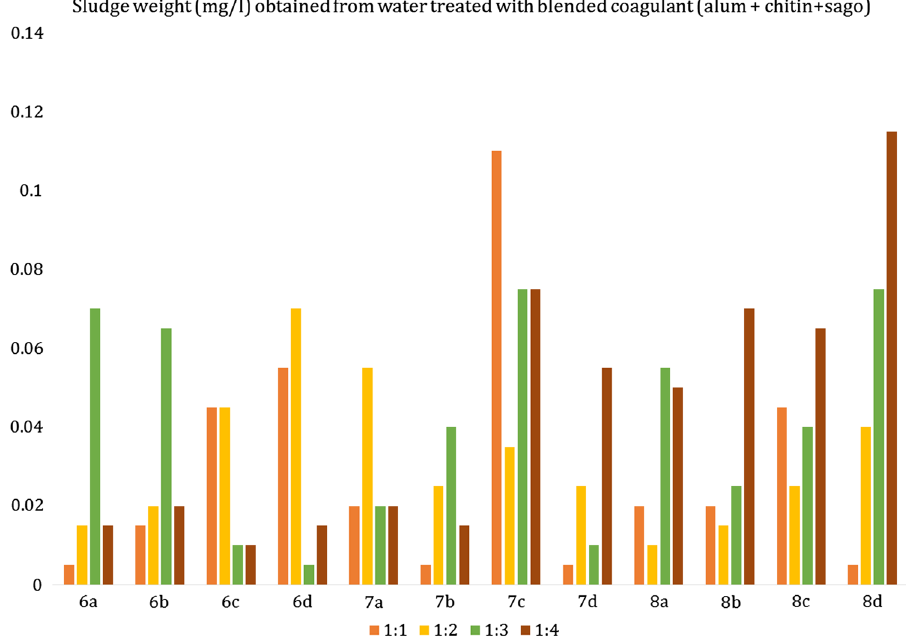
Fig. 4 Sludge weight (mg/l) obtained from water treated with blended coagulant (alum + chitin +